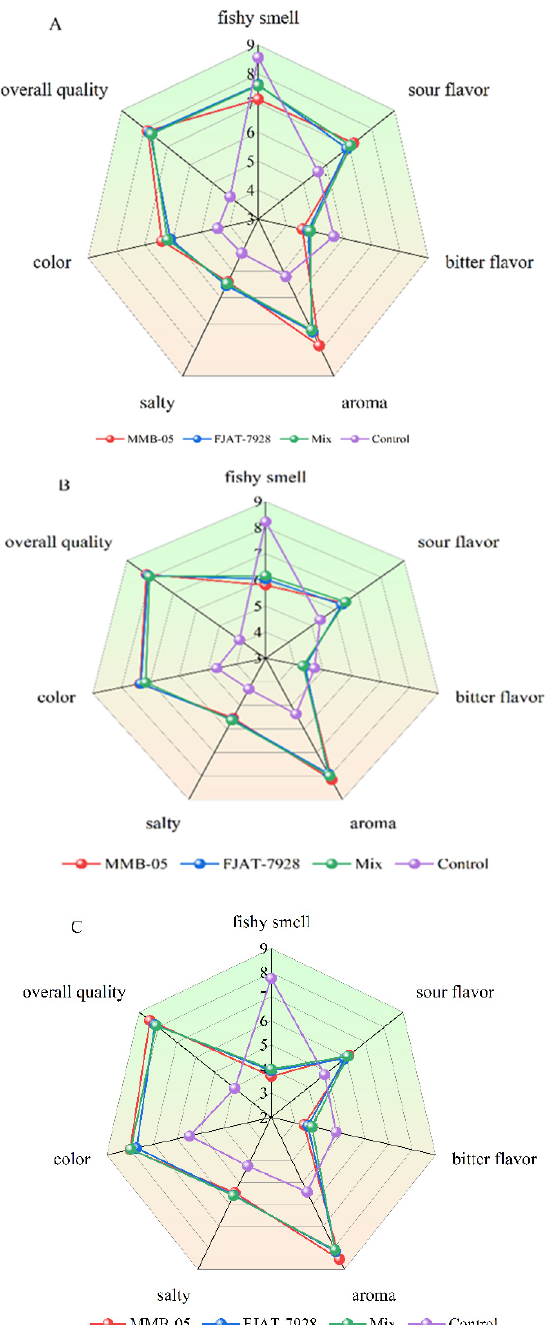
Figure 3. Sensory evaluation radars of Porphyra yezoensis sauce fermented for 24 ( A ), 48 ( B ) and 72 ( C ) h, respectively.